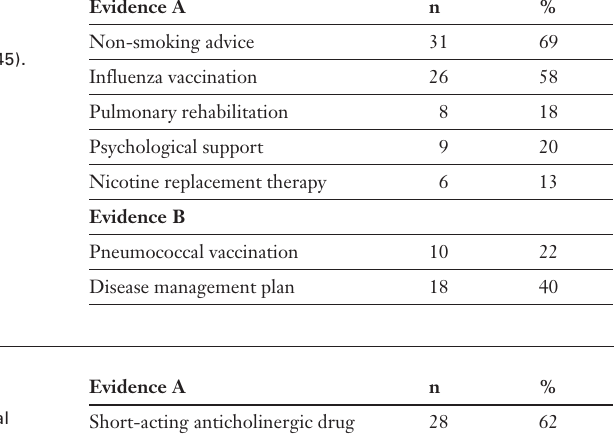
Pharmacological therapy (n = 45).